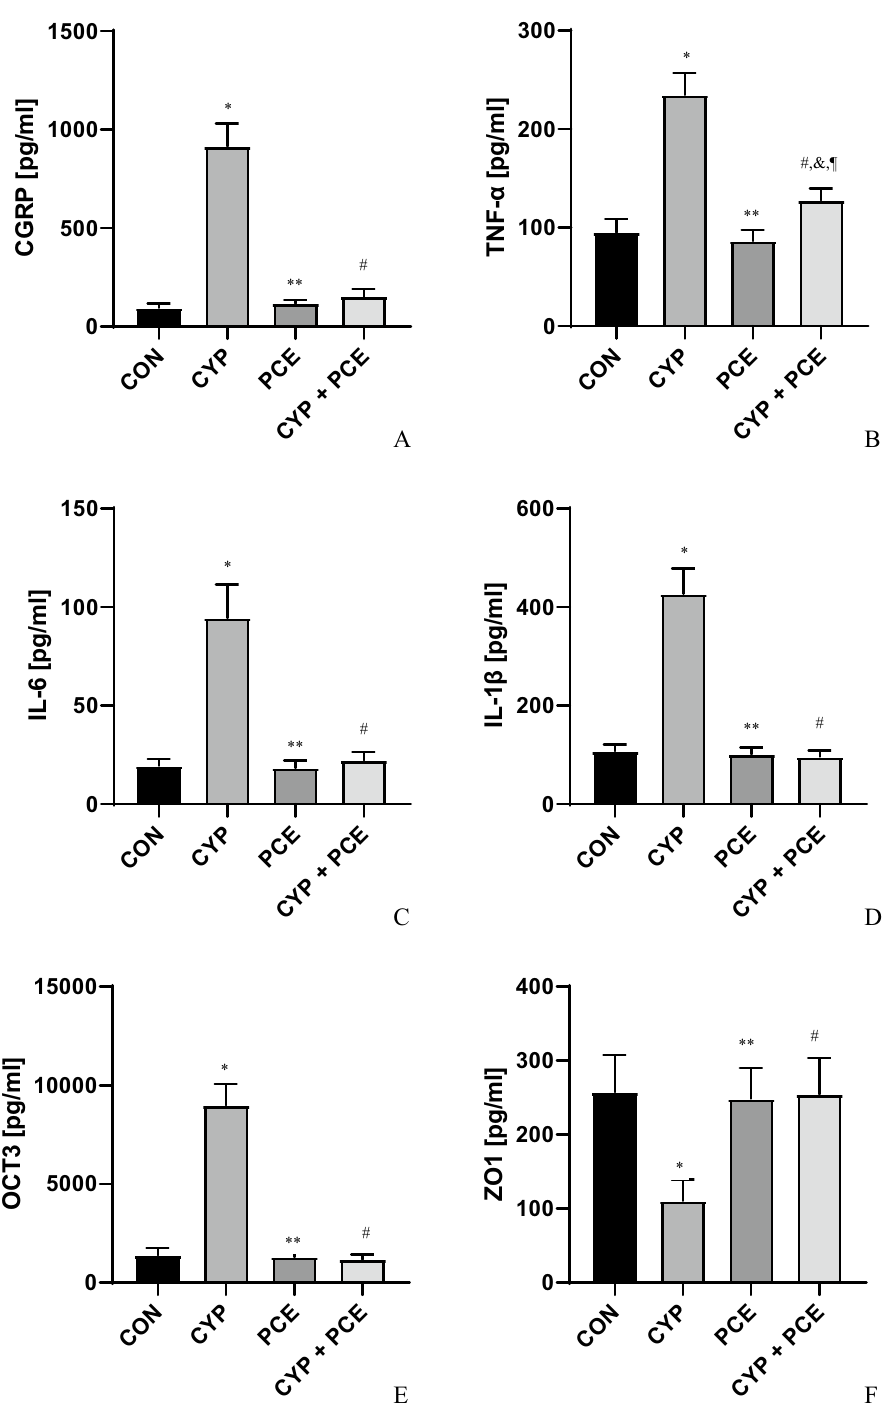
Figure 4. The influence of cyclophosphamide (CYP) and Potentilla chinensis aqueous extract (PCE) in naïve rats and PCE in rats with CYP-induced cystitis on the level of ( A ) CGRP, ( B ) TNF-α, ( C ) IL-6, ( D ) IL-1β, ( E ) OCT3, ( F ) ZO-1 in